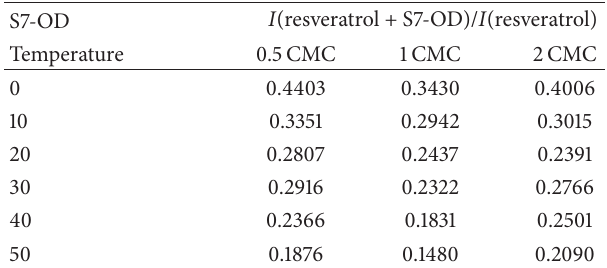
Table 2: Intensity ratio between emission of resveratrol in presence of S7-OD and resveratrol in water.